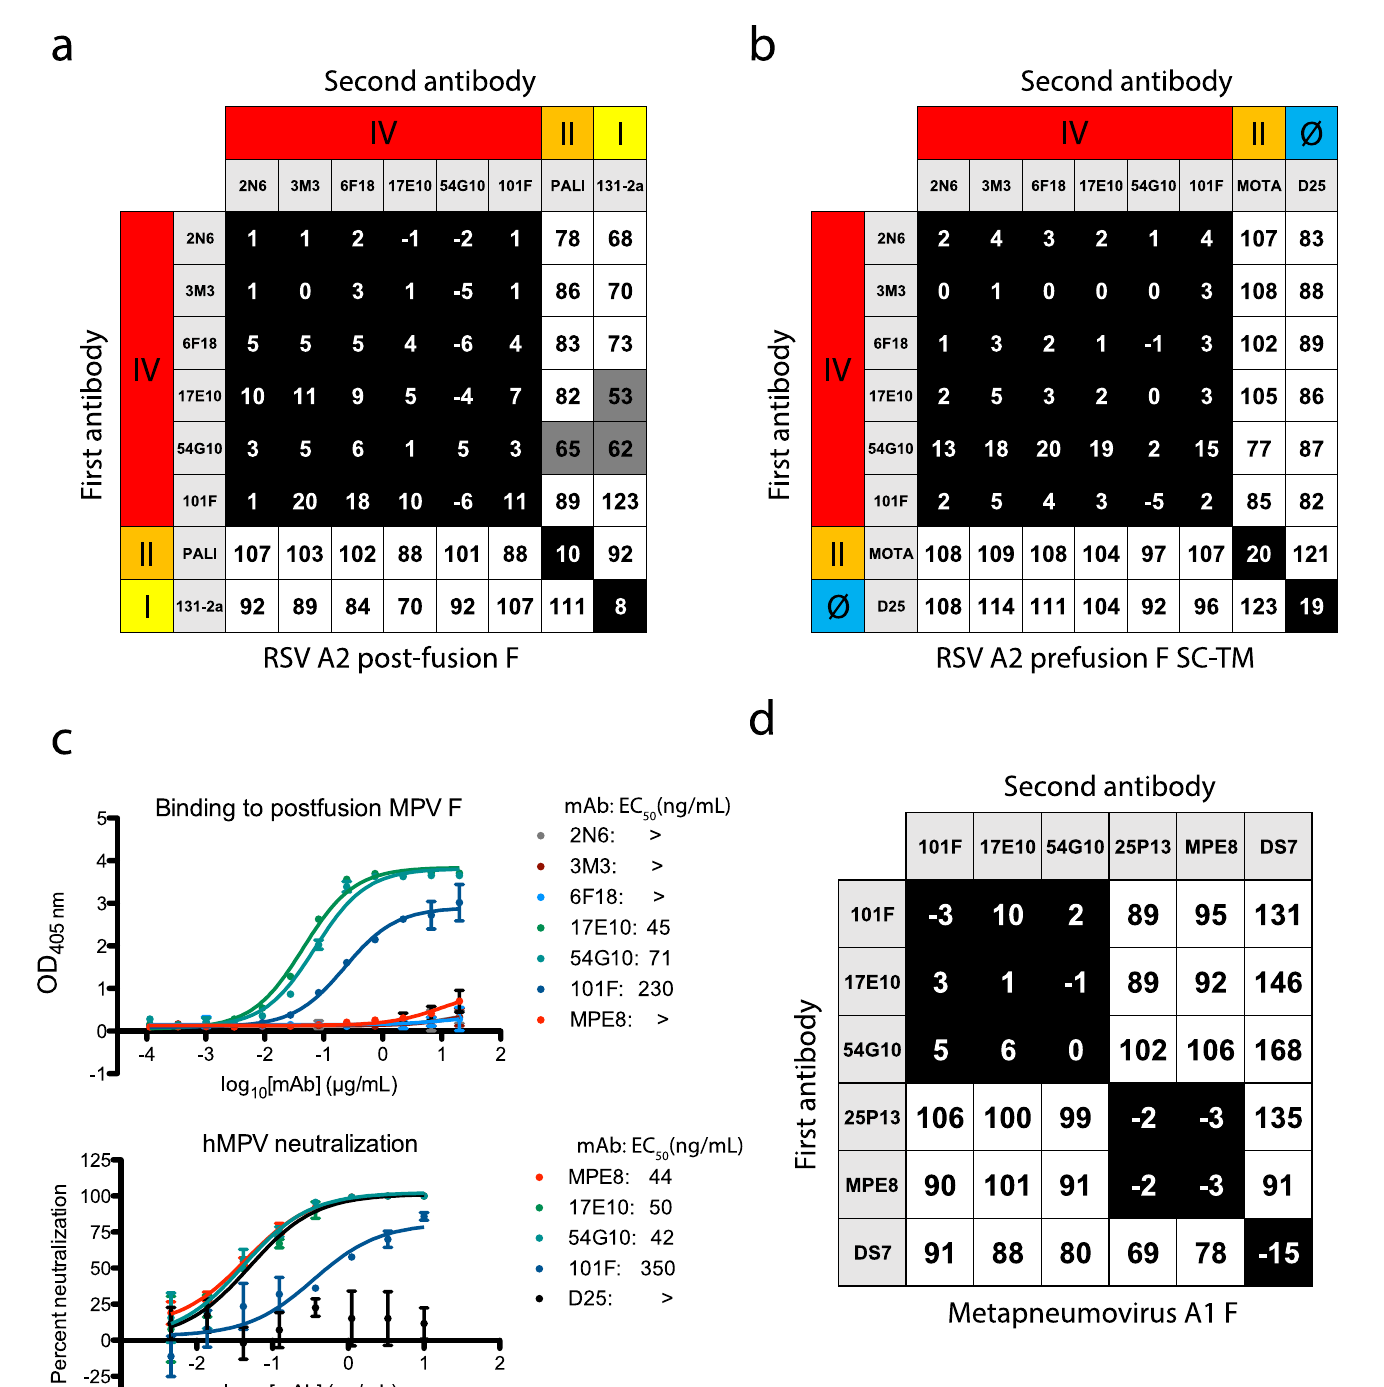
Fig 1. Epitope binning and hMPV F cross-reactivity. (A) Epitope binning with the newly generated mAbs on post-fusion RSV A2 F protein revealed the mAbs competed for binding to antigenic site IV with the previously described mAbs 101F and 54G10. (B) Epitope binning on pre-fusion RSV A2 F SC-TM suggested binding at antigenic site IV, as competition was not observed with site II mAb motavizumab nor site Ø mAb D25. (C) Binding and neutralization curves indicate mAb 17E10 cross-reacts with hMPV F. The top graph displays ELISA binding data with post-fusion hMPV A1 F protein. Only cross-reactive mAbs 17E10, 54G10, 101F, and MPE8 show binding to the protein, while the site IV mAbs 2N6, 3M3, and 6F18 show no binding. Each data point is the average of three independent experiments, each with four technical replicates. Error bars represent the standard deviation. The bottom graph show neutralization for the cross-reactive mAbs, with D25 used as a negative control. MAbs 17E10, MPE8, and 101F neutralize hMPV F while the D25 control shows no reduction in virus. Data points are the